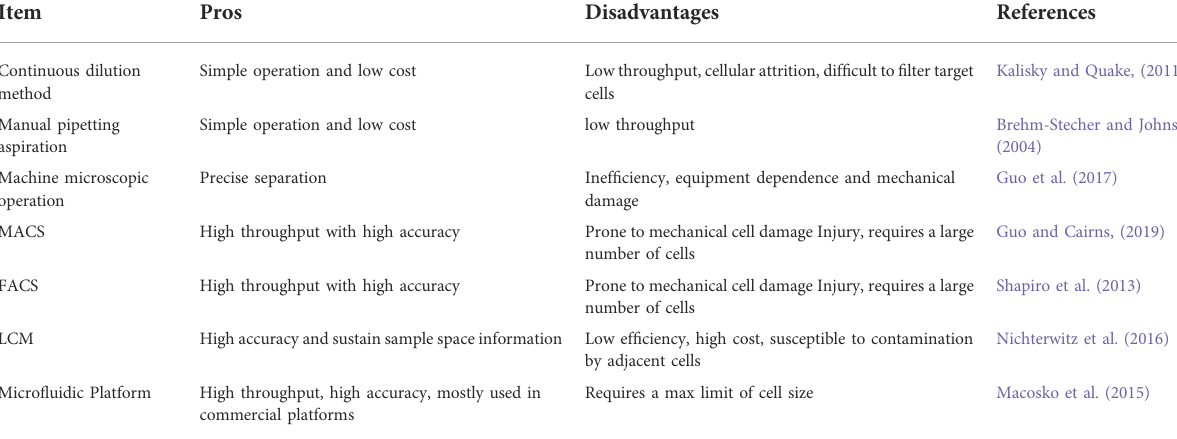
TABLE 1 Single cell separation method.